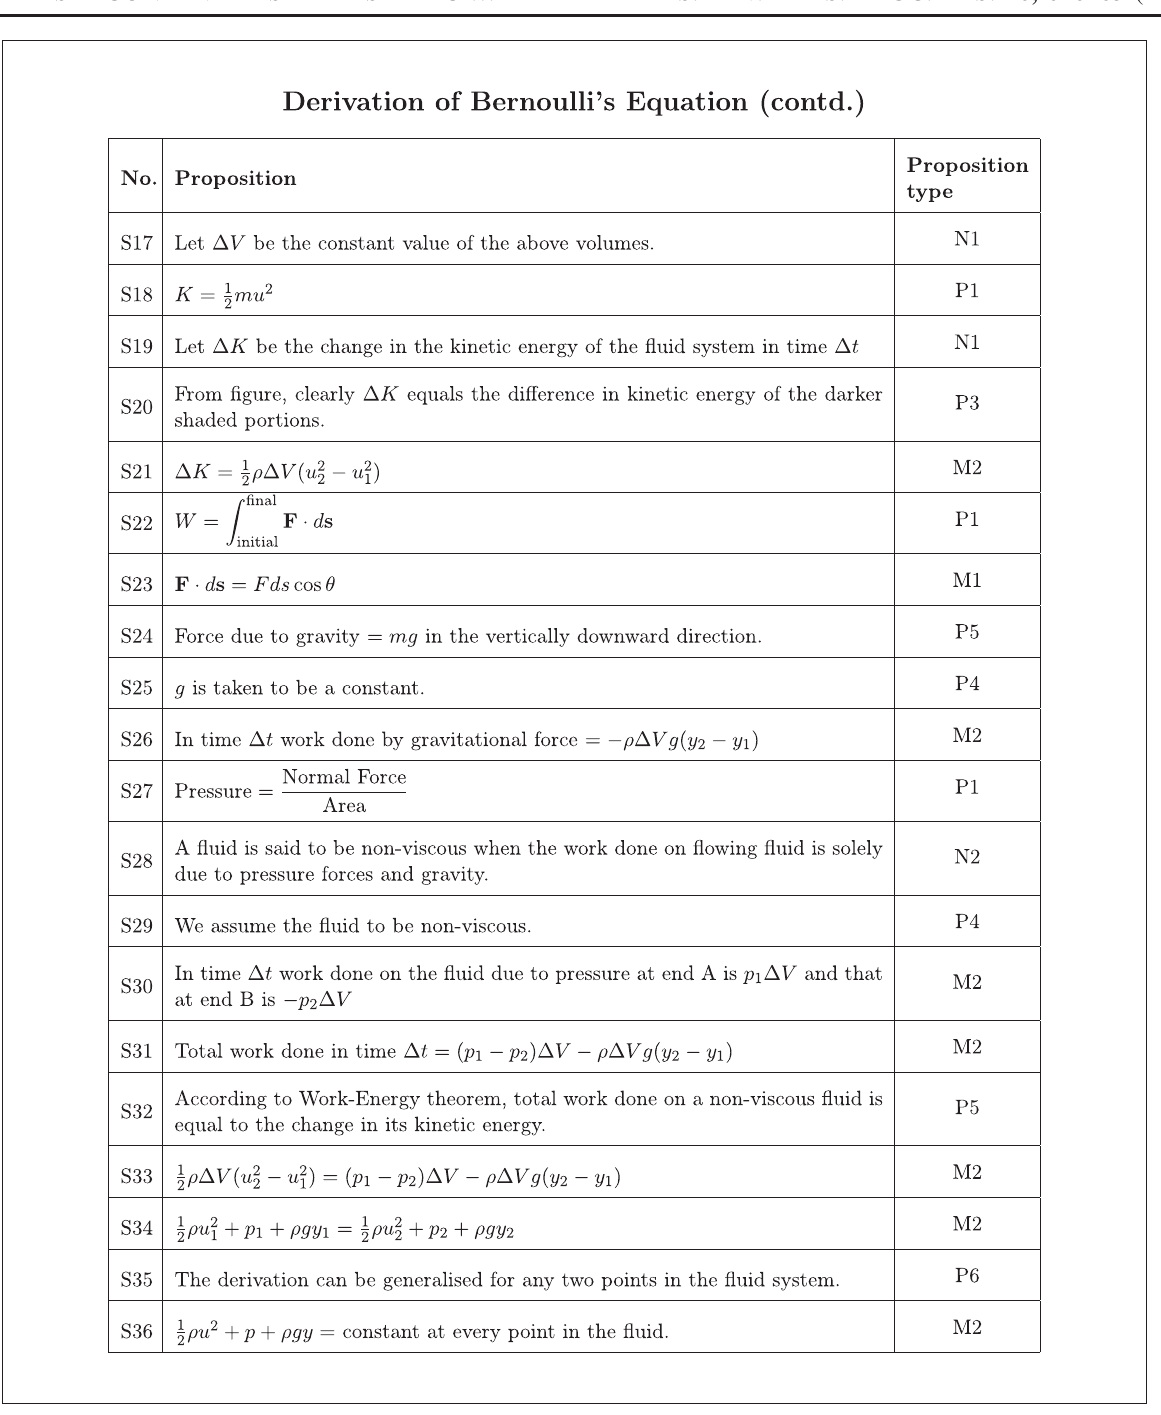
FIG. 18. Diagnostic tool for epistemic understanding: (V) Derivation of Bernoulli ’ s equation (part 3). Note: Expert answers have been filled in this